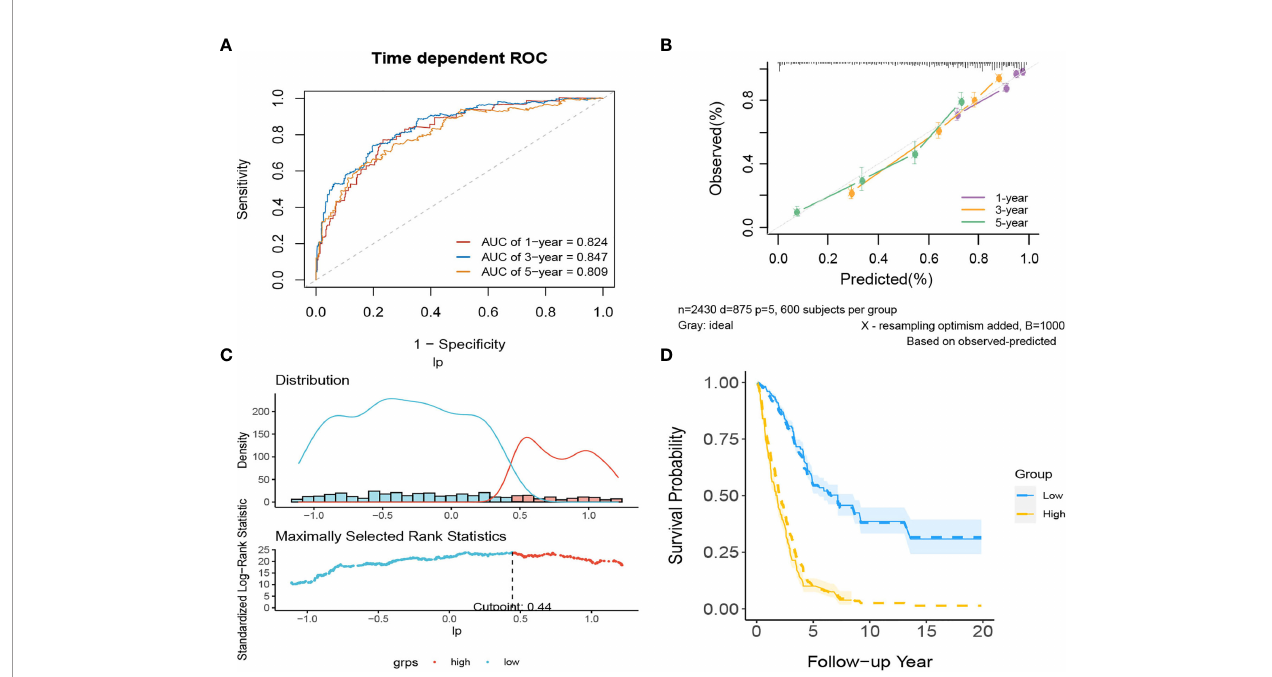
FIGURE 11 | The performance of the comprehensive model in the derivation dataset. (A) 1-,3-,5-year ROC curves and (B) calibration plot of the comprehensive model. (C) The optimal cutoff value of PI. (D) Predicted versus observed survival probability per risk group.